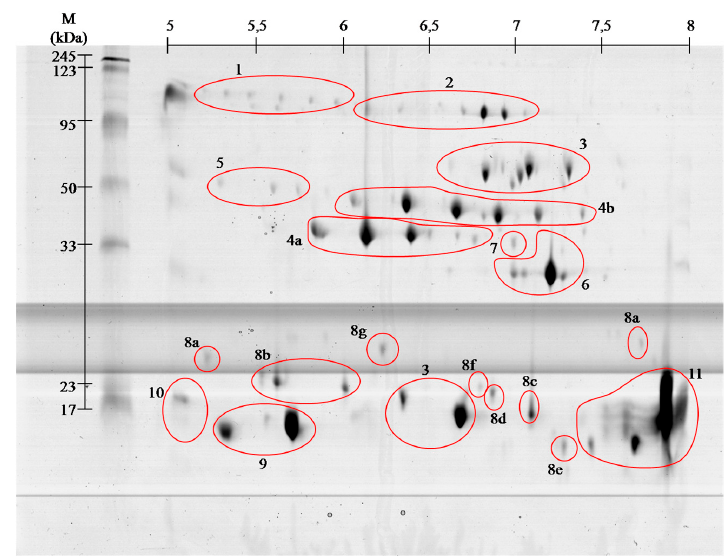
Figure 2. Representative 2-D protein map in 5–8 pH range, obtained from V. berus berus venom with identified protein groups shown: 1 , Angiotensin-like peptide; 2 , Metalloproteinase H3; 3 , L -amino acid oxidase; 4 , Serine proteases: ( a ) VLSp and ( b ) nikobin; 5 , Beta-fibrogenase brevinase; 6 , Cysteine rich venom protein; 7 , Snake venom metalloproteinases; 8 , Snaclec: ( a ) rhinocetin, ( b ) snaclec 14, ( c ) snaclec B6, ( d ) echicetin, ( e ) snaclec 1, ( f ) rhodocetin/A13, and ( g ) jerdonibitin; 9 , Acidic phospholipases; 10 , Basic phospholipases; and 11 , Neutral phospholipase. The proteins were